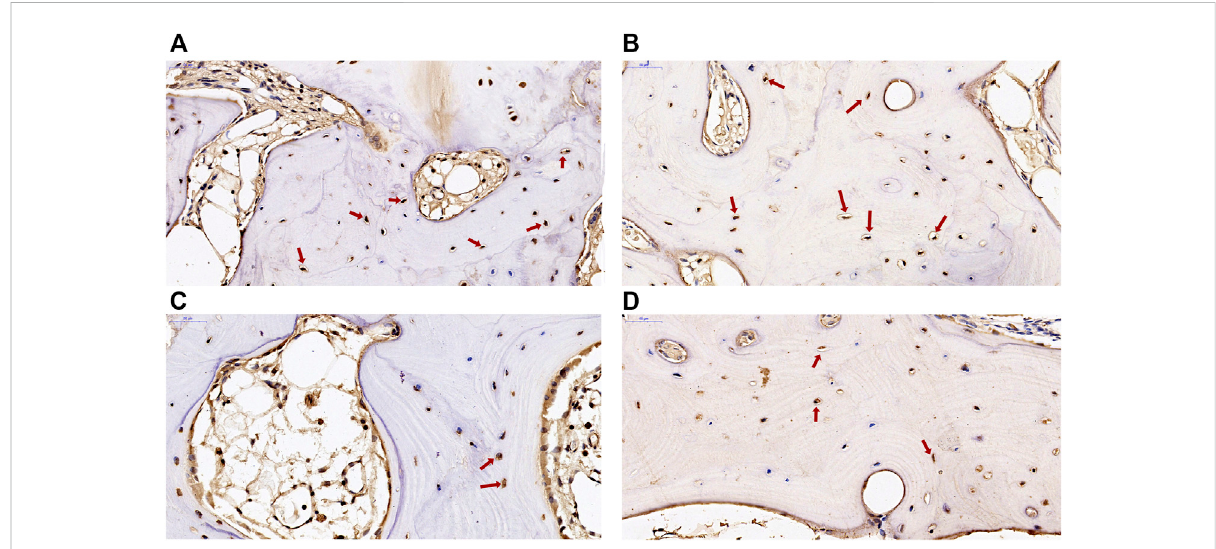
FIGURE 7 Immunohistochemical staining of ADAMTS14 and SLC13A5 in subchondral bone from patients with KBD and OA. (A,B) , the expression of ADAMTS14 in subchondral bone from patients withKBDand OA,respectively (magni fi cation:×40). (C,D) ,The expressionofSLC13A5 in subchondral bone from patients with KBD and OA, respectively (magni fi cation: ×40). The red arrows represent the positively stained